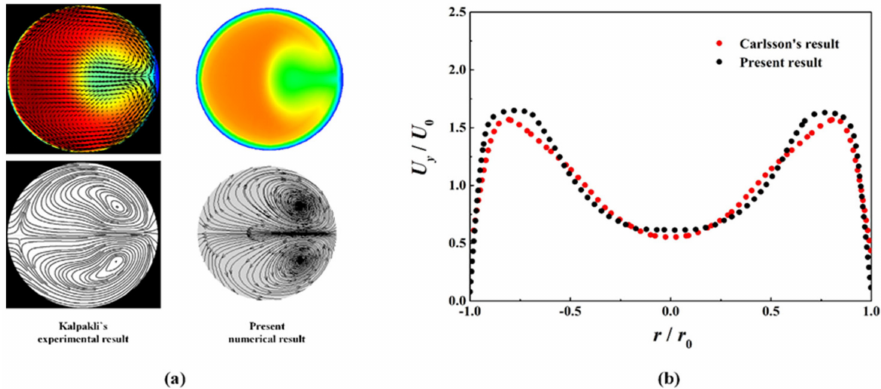
Figure 3. Verification of numerical method: ( a ) flow field distribution; ( b ) the relative velocity of the horizontal center line.